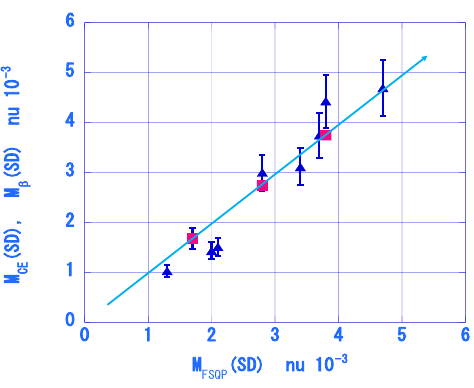
Figure 7. Energy spectrum of the ( 3 He,t) charge-exchange reactions (CER) on 76 Ge. The spin-dipole (SD) (blue) and Gamow–Teller (GT) (red/yellow) peaks are well separated, as shown in the red circle [39].